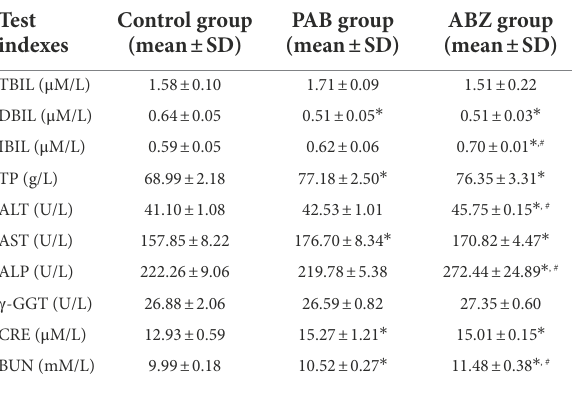
TABLE 3 Changes of biochemical indexes in the serum of E. multilocularis- infected mice after treatment with PAB for 6 weeks ( n =